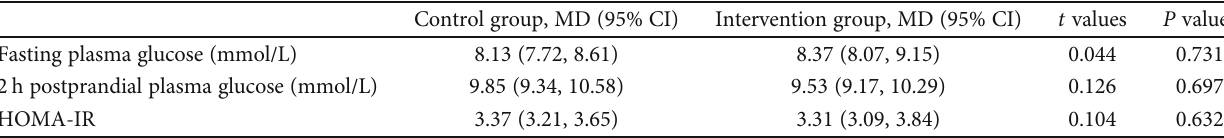
Table 6: The comparison of primary outcome between two groups.